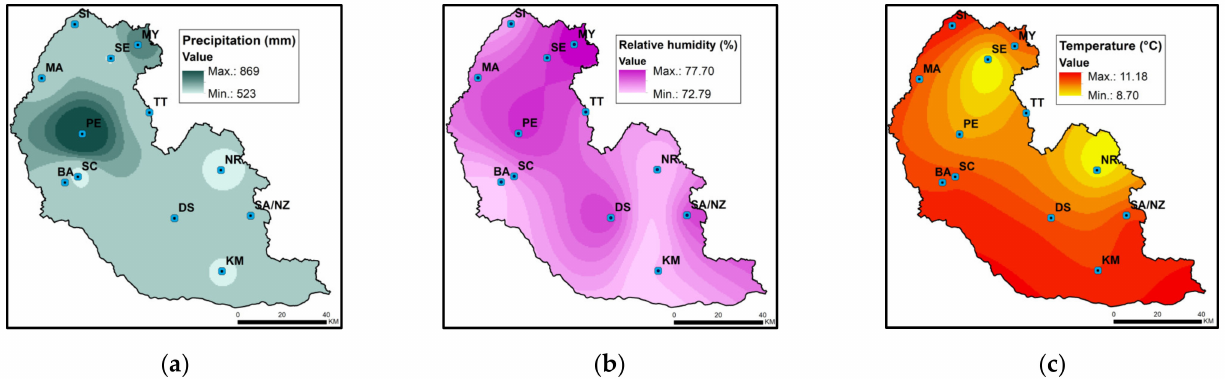
Figure 2. Spatial variability of ( a ) Pmean (mm), ( b ) rmean (%), and ( c ) Tmean ( ◦ C) during